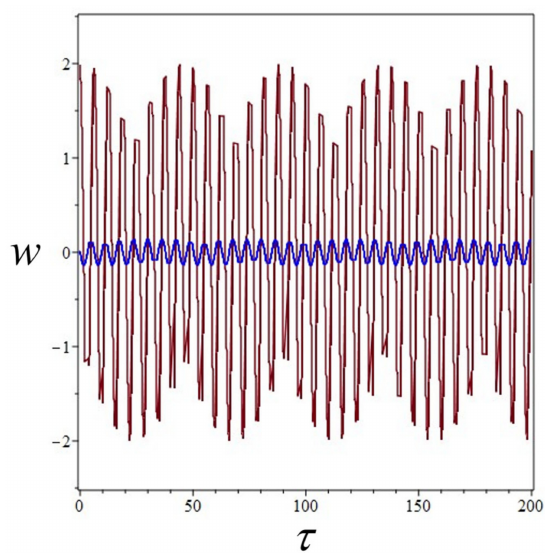
Figure 8. Frequency response for subharmonic resonance: ( a ) different damping values, ( b ) different external excitations, ( c ) different cubic nonlinear stiffness.